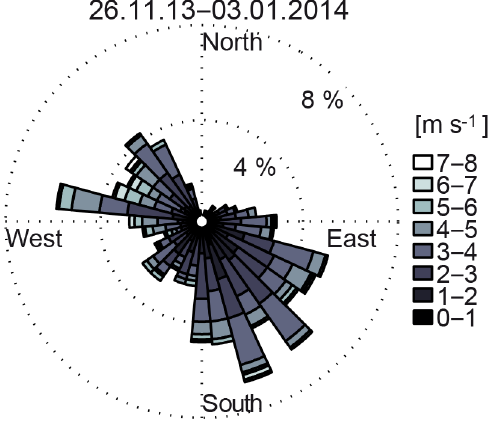
Figure 10. Wind rose for the entire study period (26 Novem- ber 2013–3 January